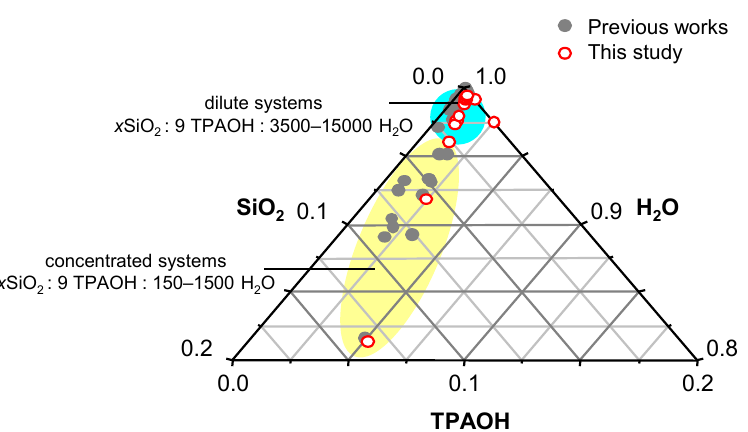
Figure 1. Typical molar composition space for silicalite-1 in the system SiO 2 -TPAOH-H 2 O occurring either in concentrated media (yellow area) as investigated by Corkery, van Santen, and Cundy et al. [12,13,24,59], or dilute systems (blue area) as studied by Davis, Tsapatsis, and Shantz et al. [3,22,27,28,41,42,50,51,60,61]. Both domains have also been extensively explored by Nikolakis, Lobo, and Martens et al. [1,2,4,10,14,17,20,25,26,62].